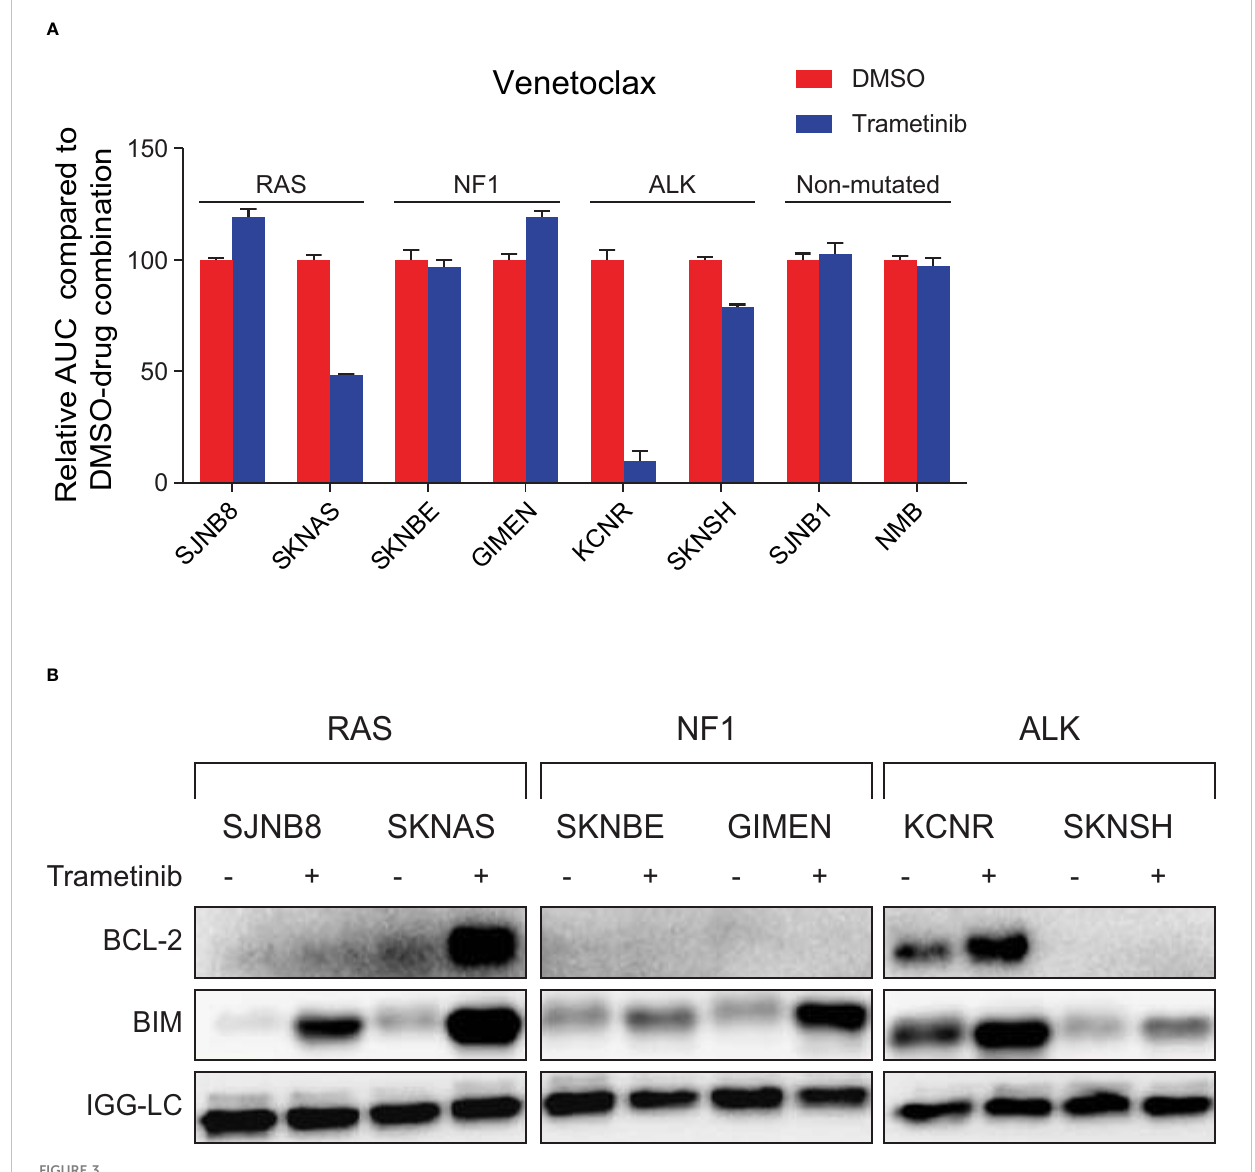
FIGURE 3 MEK inhibition sensitizes neuroblastoma cell lines with an active RAS-MAPK pathway and high BIM/BCL-2 complex expression to treatment with venetoclax. (A) Area under the curve (AUC) for a panel of cell lines treated with seven concentrations of the speci fi c BCL-2 inhibitor venetoclax combined with DMSO or trametinib. The AUC is normalized to the AUC of cells treated with venetoclax and DMSO. (B) Co-immunoprecipitation of BIM-BCL-2 complexes in lines treated with DMSO or 1 µM trametinib for 6 h. Lysates were immunoprecipitated with a BIM antibody followed by western blotting for